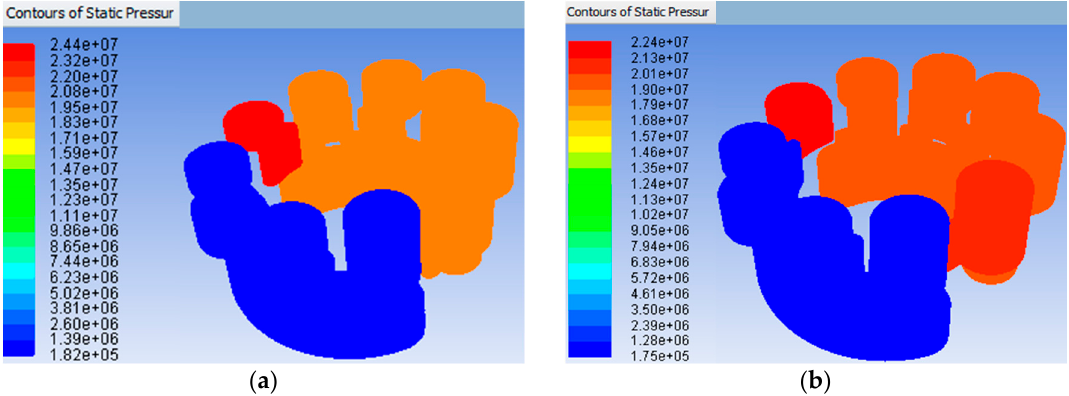
Figure 11. Pressure contours: ( a ) Before optimization; ( b ) After optimization.